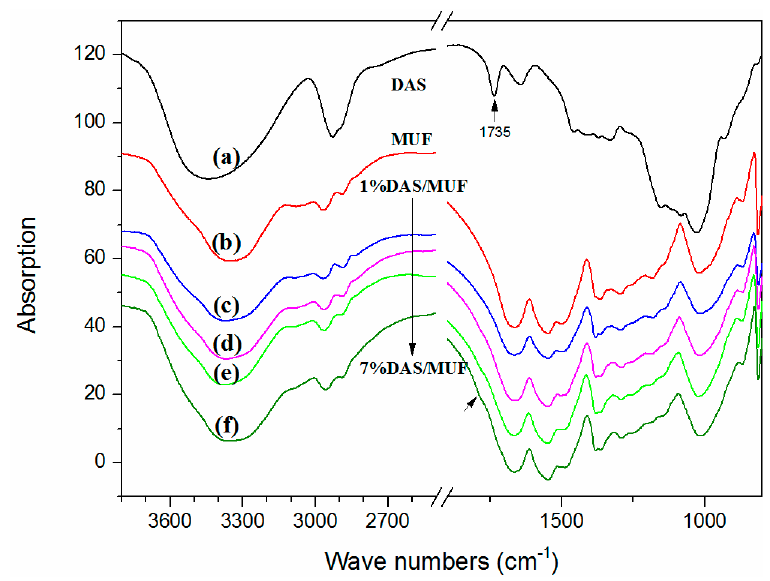
Figure 5. FTIR spectra of cured ( a ) MUF resin; ( b ) 1%DAS/MUF resin; ( c ) 3%DAS/MUF resin; ( d ) 5%DAS/MUF resin; and ( e ) 7%DAS/MUF resin. Polymers 2019 , 11 , x FOR PEER REVIEW